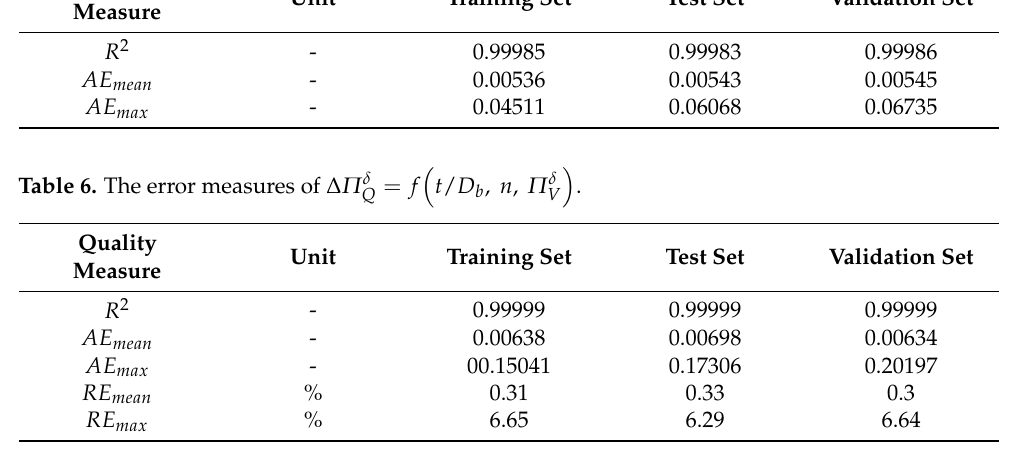
Table 5. The error measures of ∆ Π δ Quality